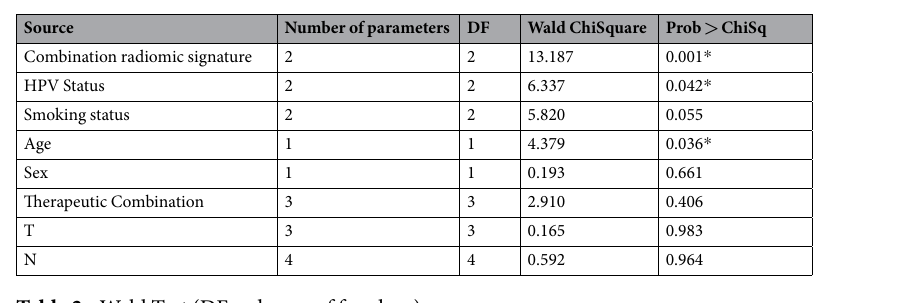
Table 2. Wald Test (DF = degree of